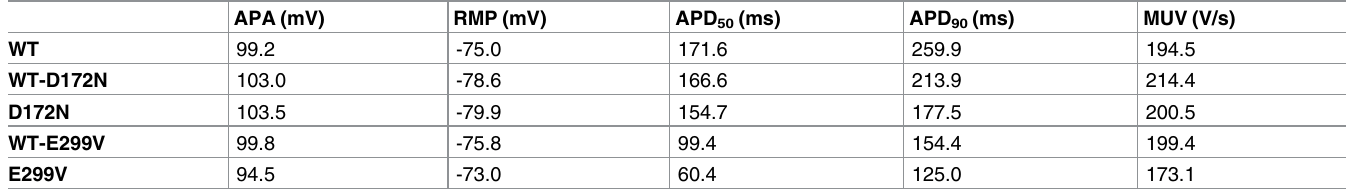
Table 1. AP properties in WT and SQT3 mutant conditions in the baseline single cell